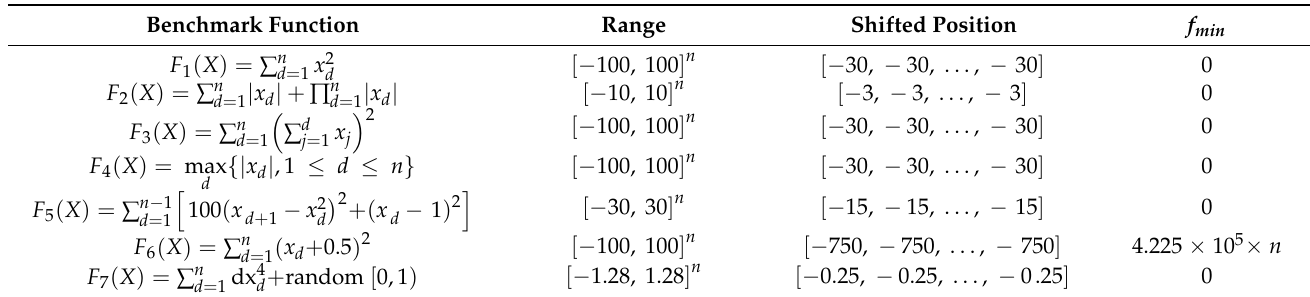
Table 1. The shifted uni-modal benchmark functions. Benchmark Function